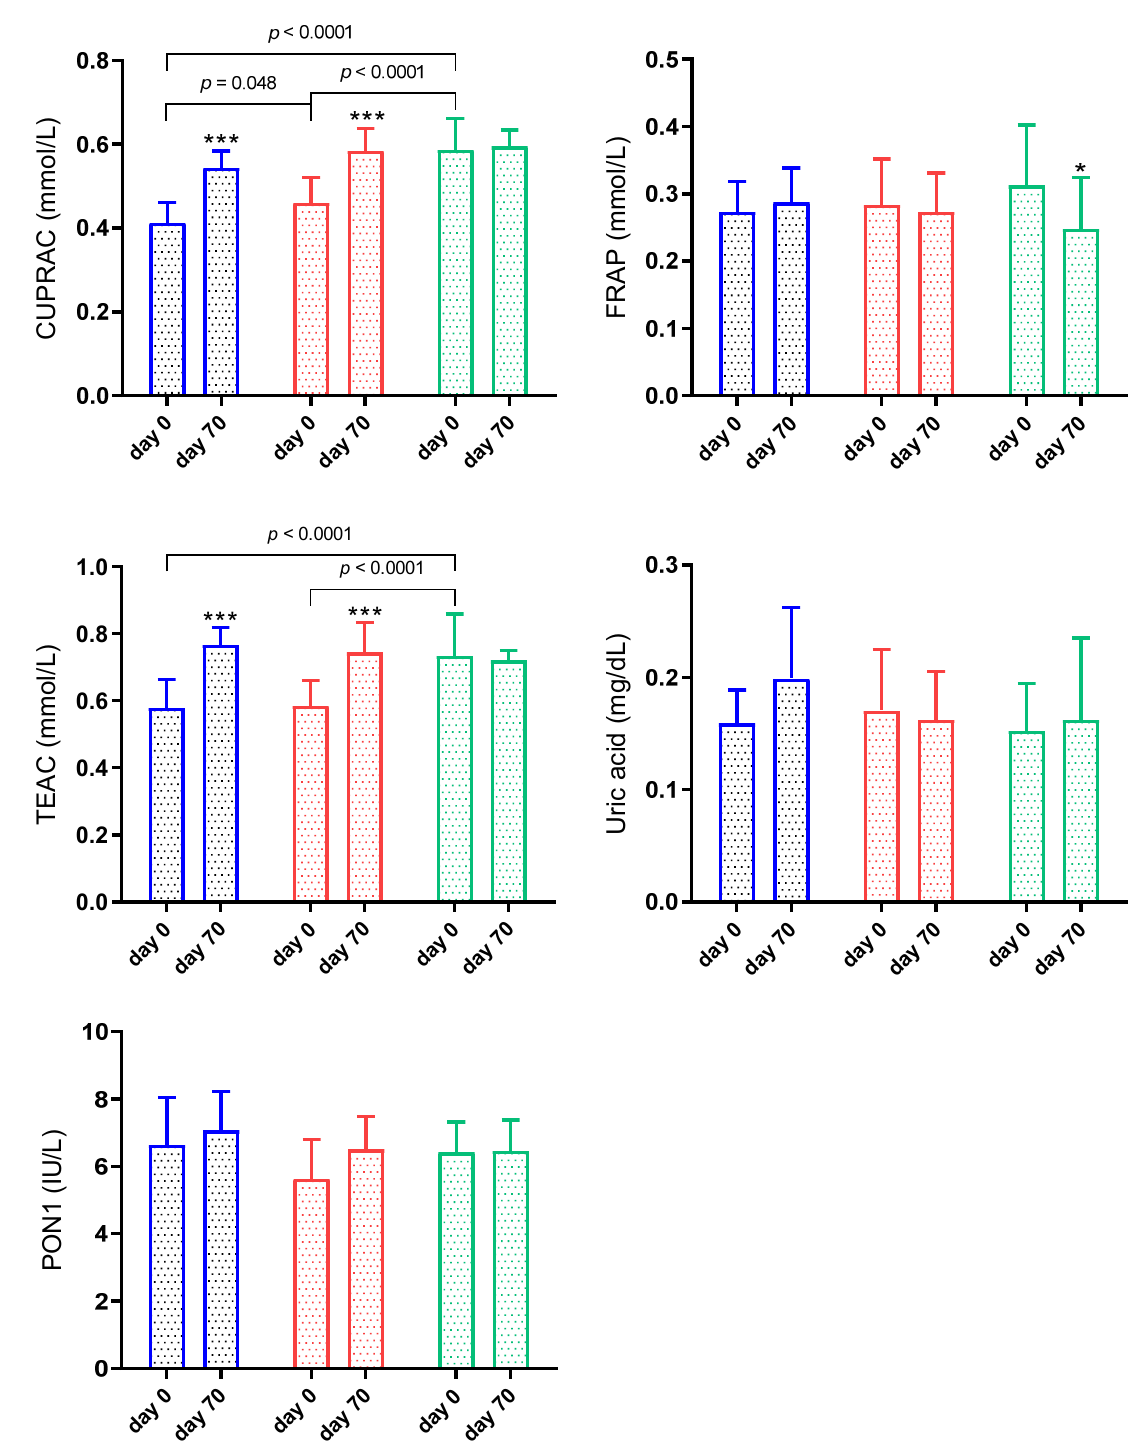
Figure 3. Results for cupric reducing antioxidant capacity (CUPRAC), ferric reducing ability of plasma (FRAP), Trolox equivalent antioxidant capacity (TEAC), uric acid and paraoxonase 1 (PON1) in sheep naturally infected by gastrointestinal nematodes. G1 (blue bar): faecal worm egg counts (EPG) higher than 5000 and packed cell volume (PCV) lower than 24%; G2 (red bar): EPG higher than 5000 and PCV higher than 24%; G3 (green bar): EPG lower than 5000 and PCV higher than 24%. Asterisks indicate significantly different from day 0. * p < 0.05; *** p < 0.001.